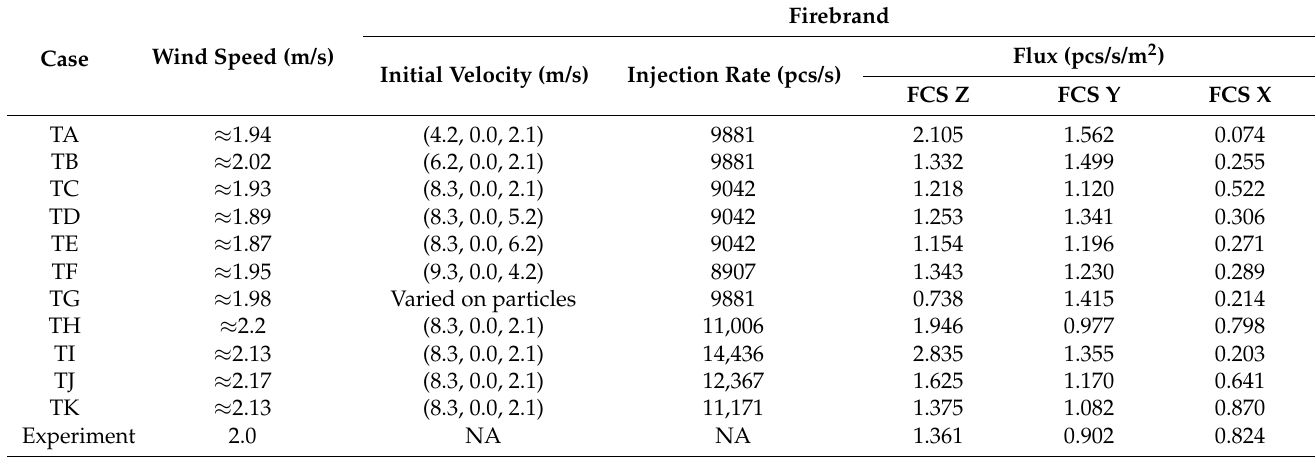
Table 8. Firebrand flux at Z, Y, X firebrand collection centers in a few trials of the inverse